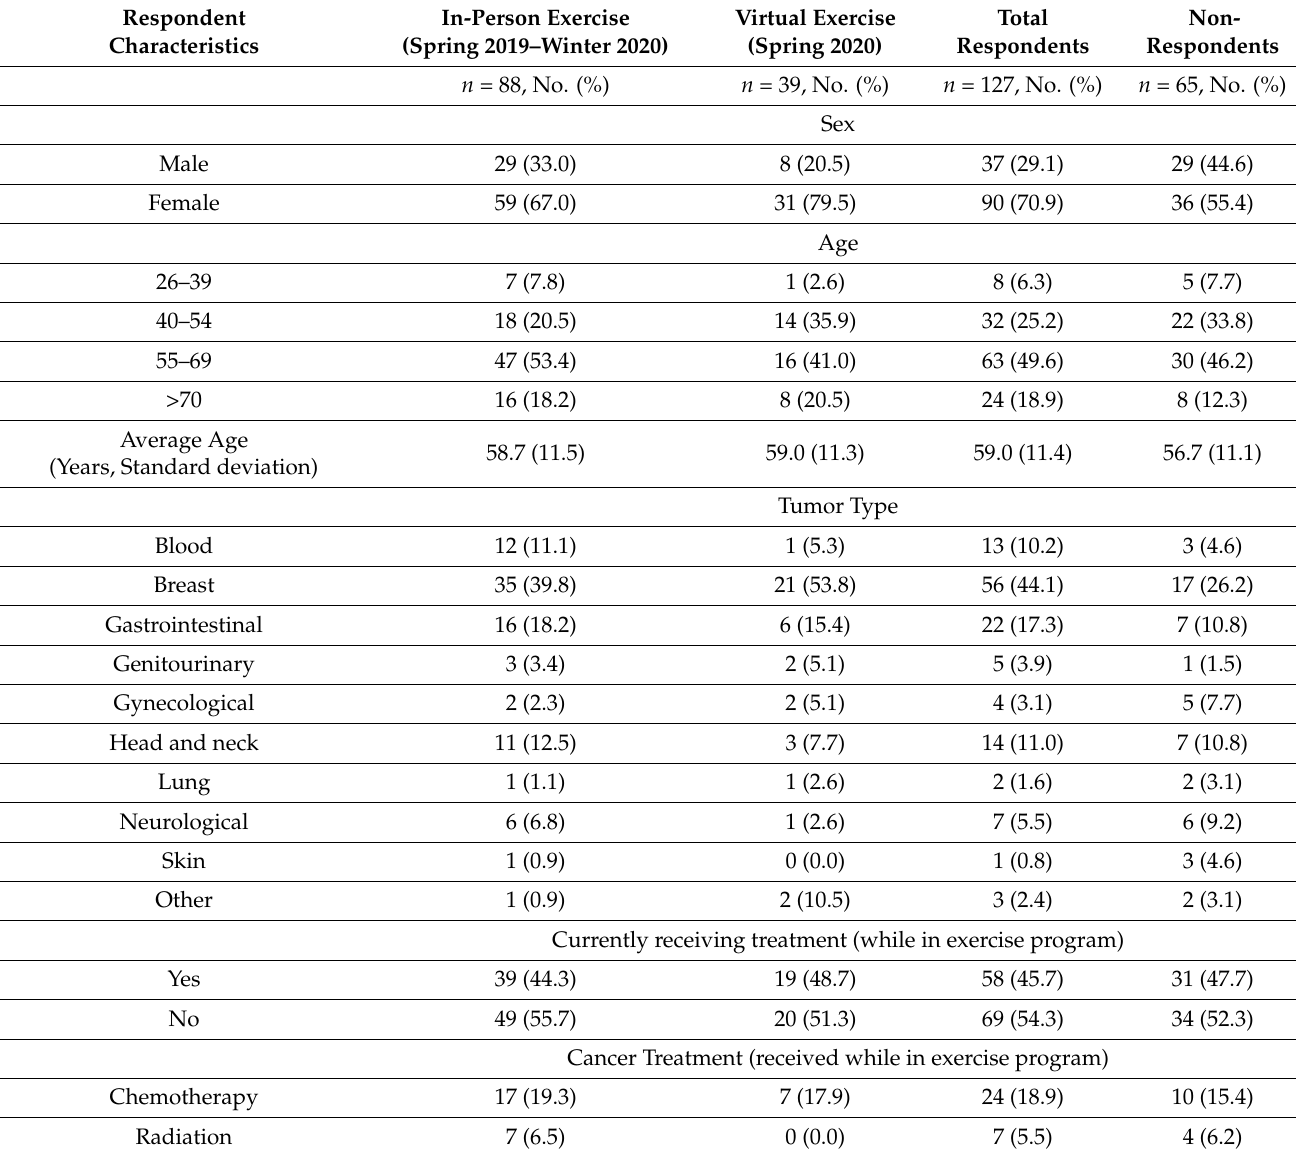
Table 2. Baseline Demographic and Medical